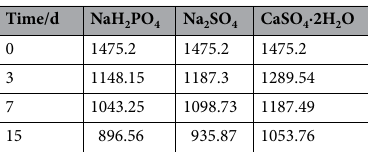
Table 4. Active mass fraction of cadmium after passivating agent